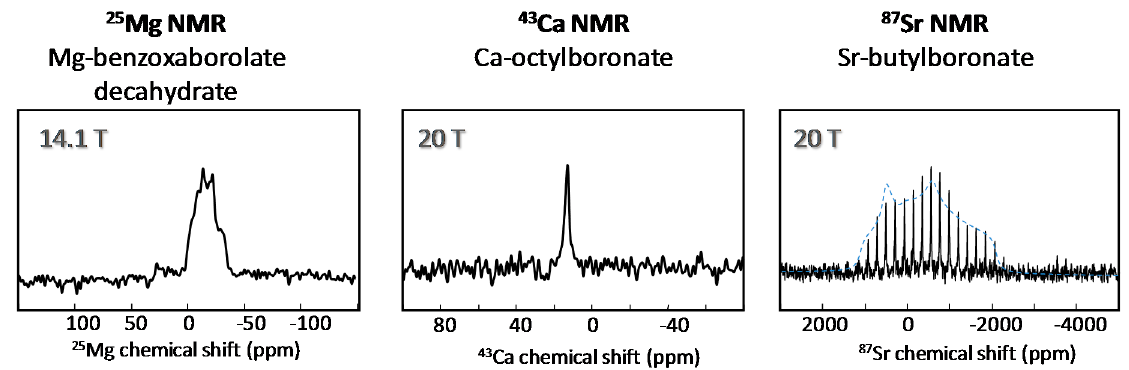
Figure 10. Natural abundance 25 Mg, 43 Ca and 87 Sr solid state NMR spectra of metal boronates/benzoxaborolates, recorded at 14.1 or 20 T. The experimental conditions for each spectrum can be found in the corresponding publications. Adapted with permission from [24] (copyright Wiley-VCH, 2015), and [27] (copyright American Chemical Society, 2015).